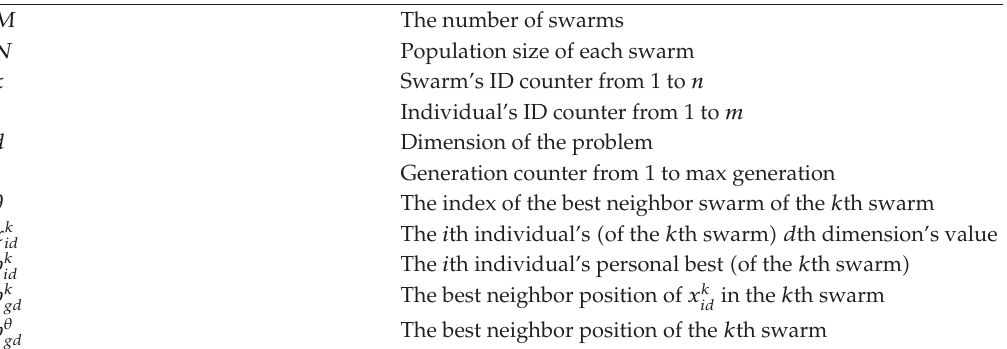
Table 2: List of variables used in PS 2